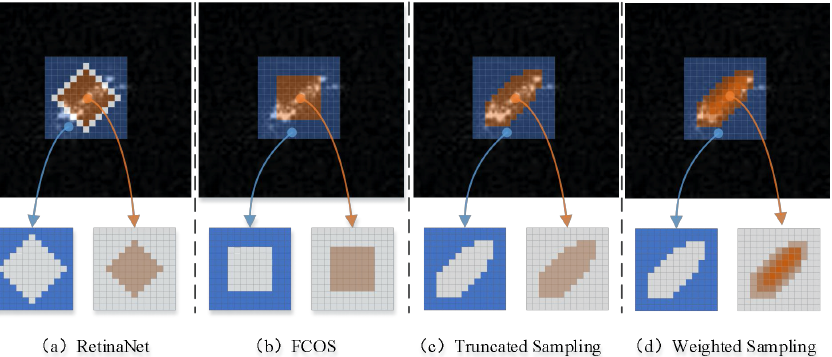
Figure 8. Positive sample distribution for different sampling strategies. ( a ) RetinaNet; ( b ) FCOS; ( c ) Truncated Sampling; ( d ) Weighted